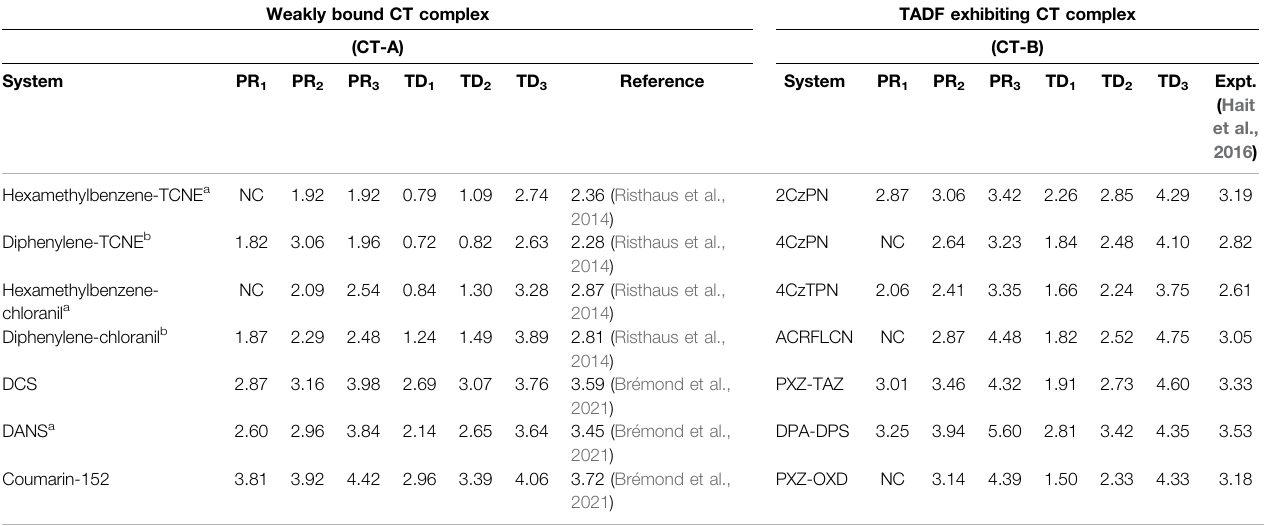
TABLE 16 | E 0S from the present result (PR) and TDDFT (TD) in some CT complexes. NC implies “ not converged. ” More details are available in Roy et al. (2022).